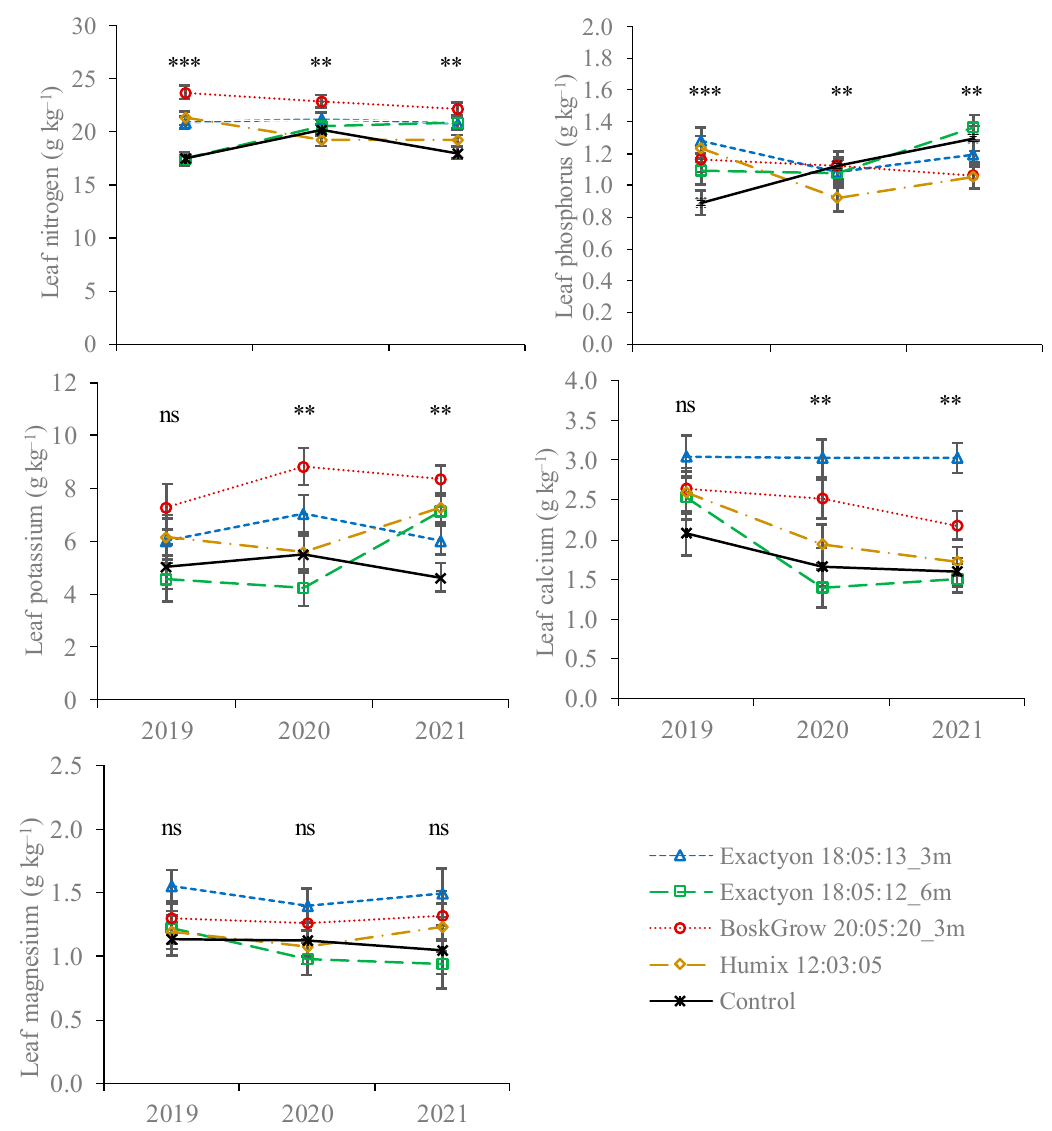
Figure 2. Average concentration and standard error of the mean of nitrogen, phosphorus, potassium, calcium and magnesium of chestnut leaves collected in July of 2019, 2020 and 2021 as a function of fertilization treatments. ** p ≤ 0.01; *** p ≤ 0.001; ns, not significant. Table 1. Nutrient concentration in the kernels from the harvests of 2019 and 2021 as a function of the Leaf B levels varied significantly between fertilization treatments on the three sam- pling dates (Figure 3). The values in the plots treated with Exactyon 18:05:13_3m and Ex- actyon 18:05:12_6m increased markedly from the first to the last sampling date, from av- erage values close to 25 mg kg − 1 to values around 80 mg kg − 1 . The values of the BoskGrow 20:05:20_3m treatment also showed a slight increase on the third sampling date in com- parison to those of the Humic 12:03:05 and control treatments. The Fe concentration in the leaves showed an increasing trend over the years, but without a clear consistency in the relative position of the different fertilization treatments. The control showed consistently lower leaf Mn levels on the three sampling dates (873 to 1363 mg kg − 1 ) compared to any of the fertilized treatments (1739 to 2533 mg kg − 1 ). Leaf Zn and Cu levels did not vary significantly between treatments.